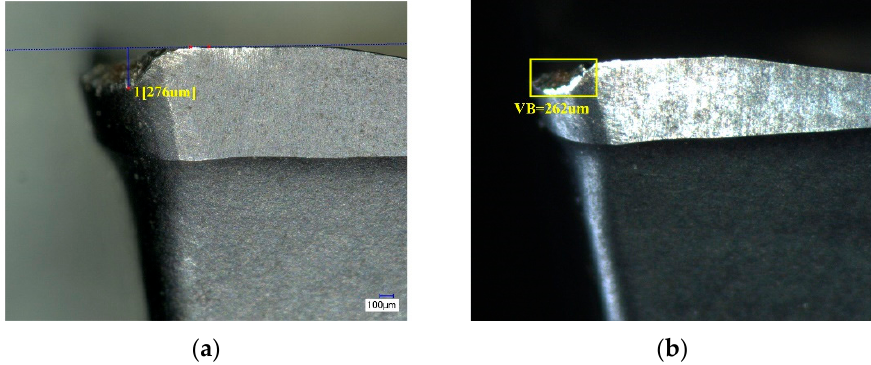
Figure 10. Comparison of two acquisition methods. ( a ) image is manually collected by high precision digital microscope (model: Keyence VHX-1000); ( b ) image is collected by the automatic acquisition device.